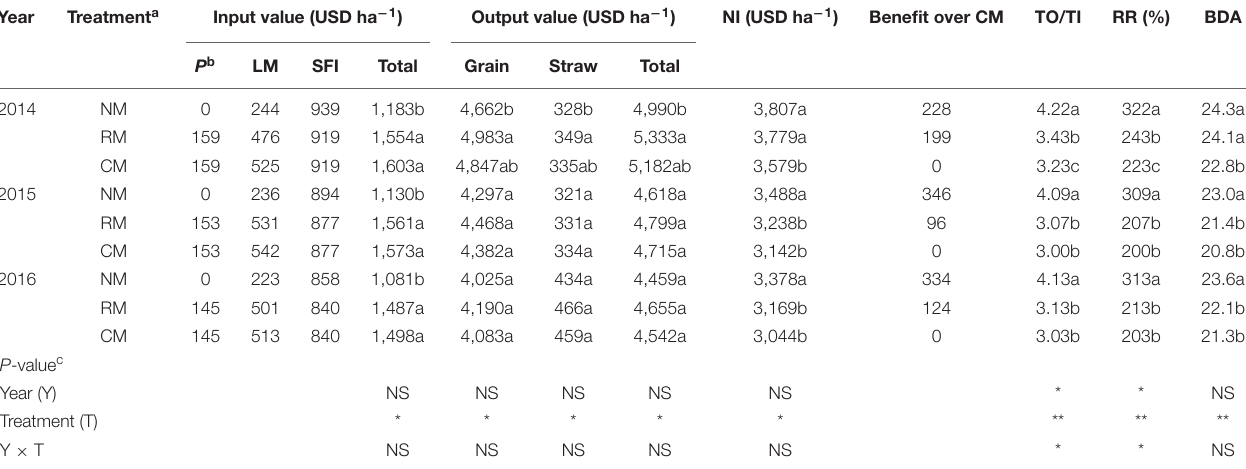
TABLE 5 | Analysis on economic benefit for maize production under different plastic management practices from 2014 to 2016 in an arid oasis